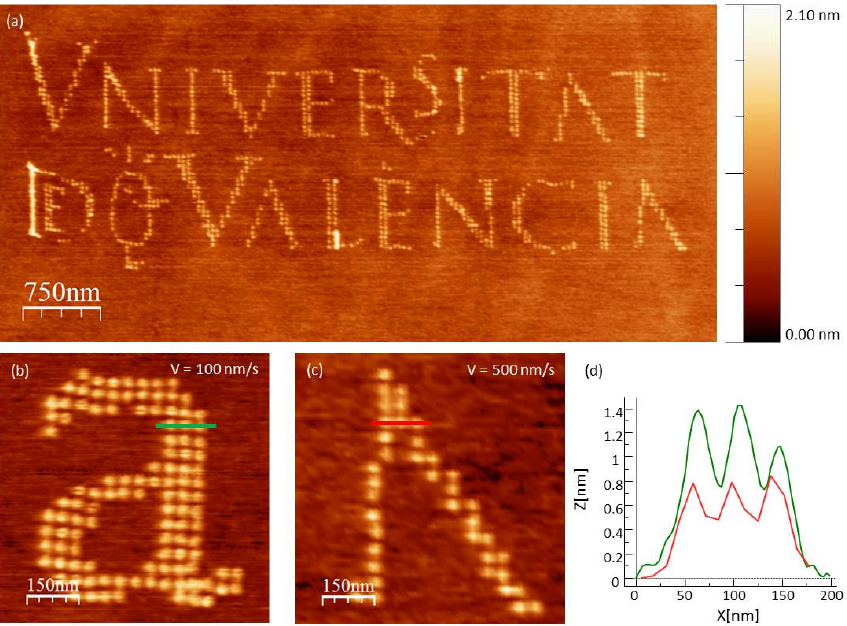
Figure 4. Static-tip LON performed on TaS 2 thick flakes. ( a ) AFM topography image patterned with a university logo made out of 1040 oxide dots, oxidized at − 34 V and 150 ms. Average dot heights are 0.58 ± 0.15 nm; ( b ) Topography image of an oxide pattern performed at a constant voltage value of − 34 V and 150 ms. The oxide dots were grown at v = 100 nm/s scan speed; ( c ) Topography image extracted from a selected region of Figure 4a. The oxide dots were grown at v = 500 nm/s scan speed; ( d ) Height profiles of three consecutive oxide dots in ( b ) green line and ( c ) red line.